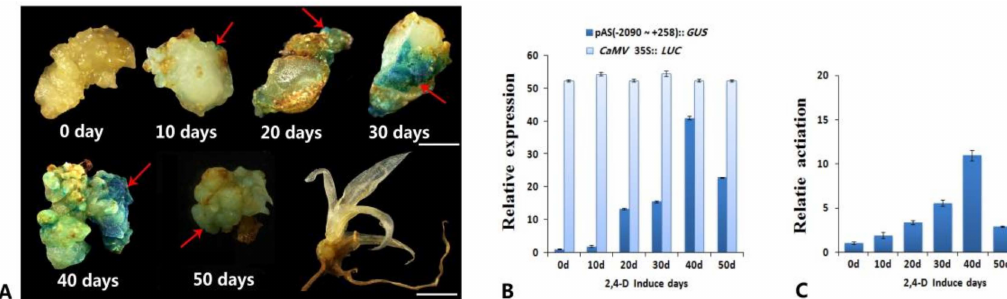
Figure 1. Transient expression analysis of promoter activity of the 5’ upstream regulatory sequence of AcSERK1 . Callus was isolated after di ff erent lengths of time cultured in embryonic induction medium and analyzed by GUS histochemical staining. Red arrows indicate areas of GUS expression: ( A ) 0 days (d, i.e., non-embryonic callus), 10 days, 20 days, 30 days, 40 days, 50 days, and plant regenerated from somatic embryo (negative control). Scale bar of callus indicates 2mm, Scale bar of plant regenerated from somatic embryo indicates 5mm. ( B ) Relative expression levels of the GUS gene measured by qPCR during the induction of pineapple SE(somatic embryogenesis). Pineapple β -actin gene served as the internal control. Data represent three biological replicates and error bars denote standard error of the mean. ( C ) Quantitative GUS assay to determine embryonic specific promoter activity. Data plotted as relative promoter activity: a value of 1 indicates equal promoter activity in both embryonic and non-embryonic callus. Data represent three biological replicates, and the error bars denote standard error of the